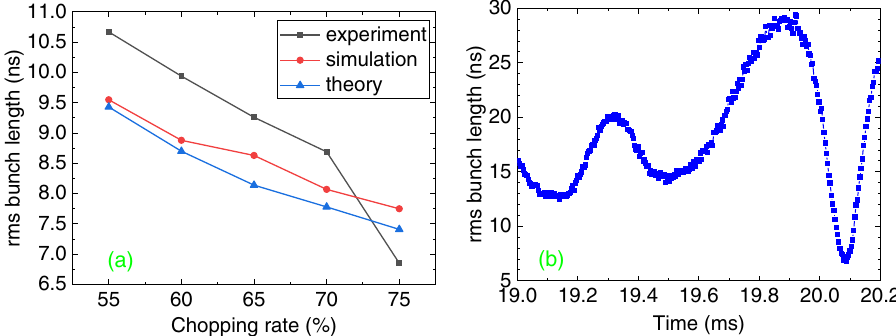
FIG. 8. (a) The changing trend of the extraction bunch length obtained by experiment, simulation, and theory under different chopping factors. (b) The dramatic effect of the quadrupole oscillation caused by the strong space charge under the chopping factor of 75% on the process of the whole bunch compression.